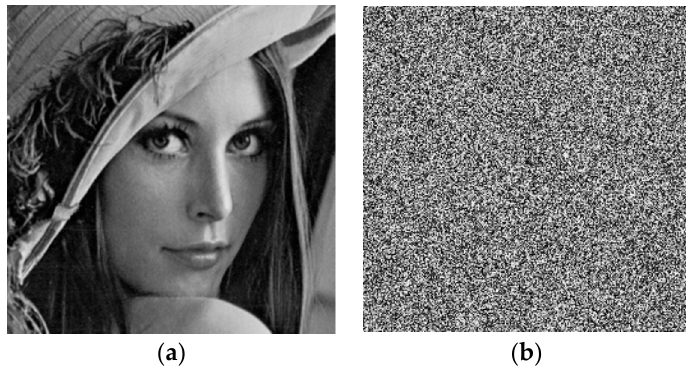
Figure 10. ( a ) Test image; ( b ) Encrypted image.